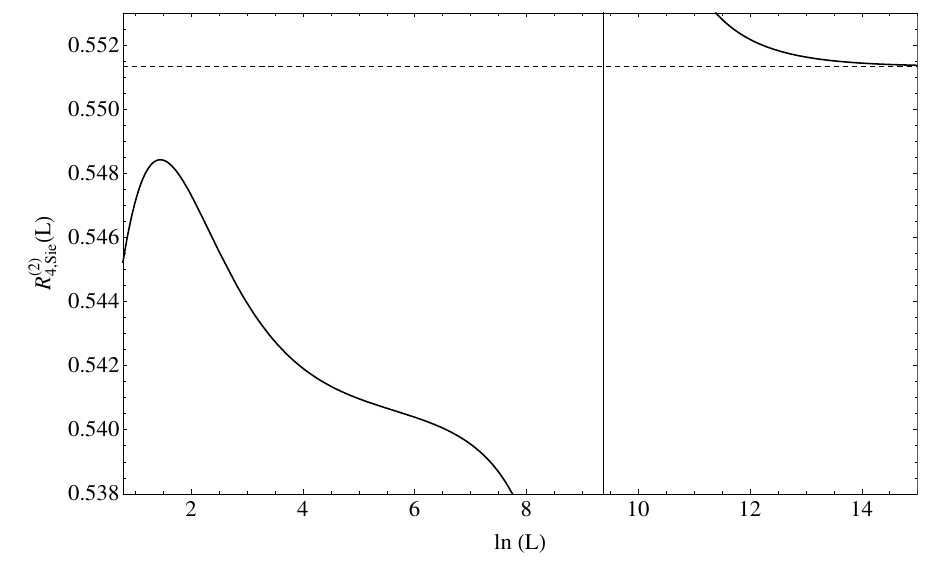
Figure 6 . Plot of R (2) ( L ) for the tachyon vev as a function of level in Siegel gauge. The dashed 4 ; Sie p line represents the conjectured value 3 =(cid:25)